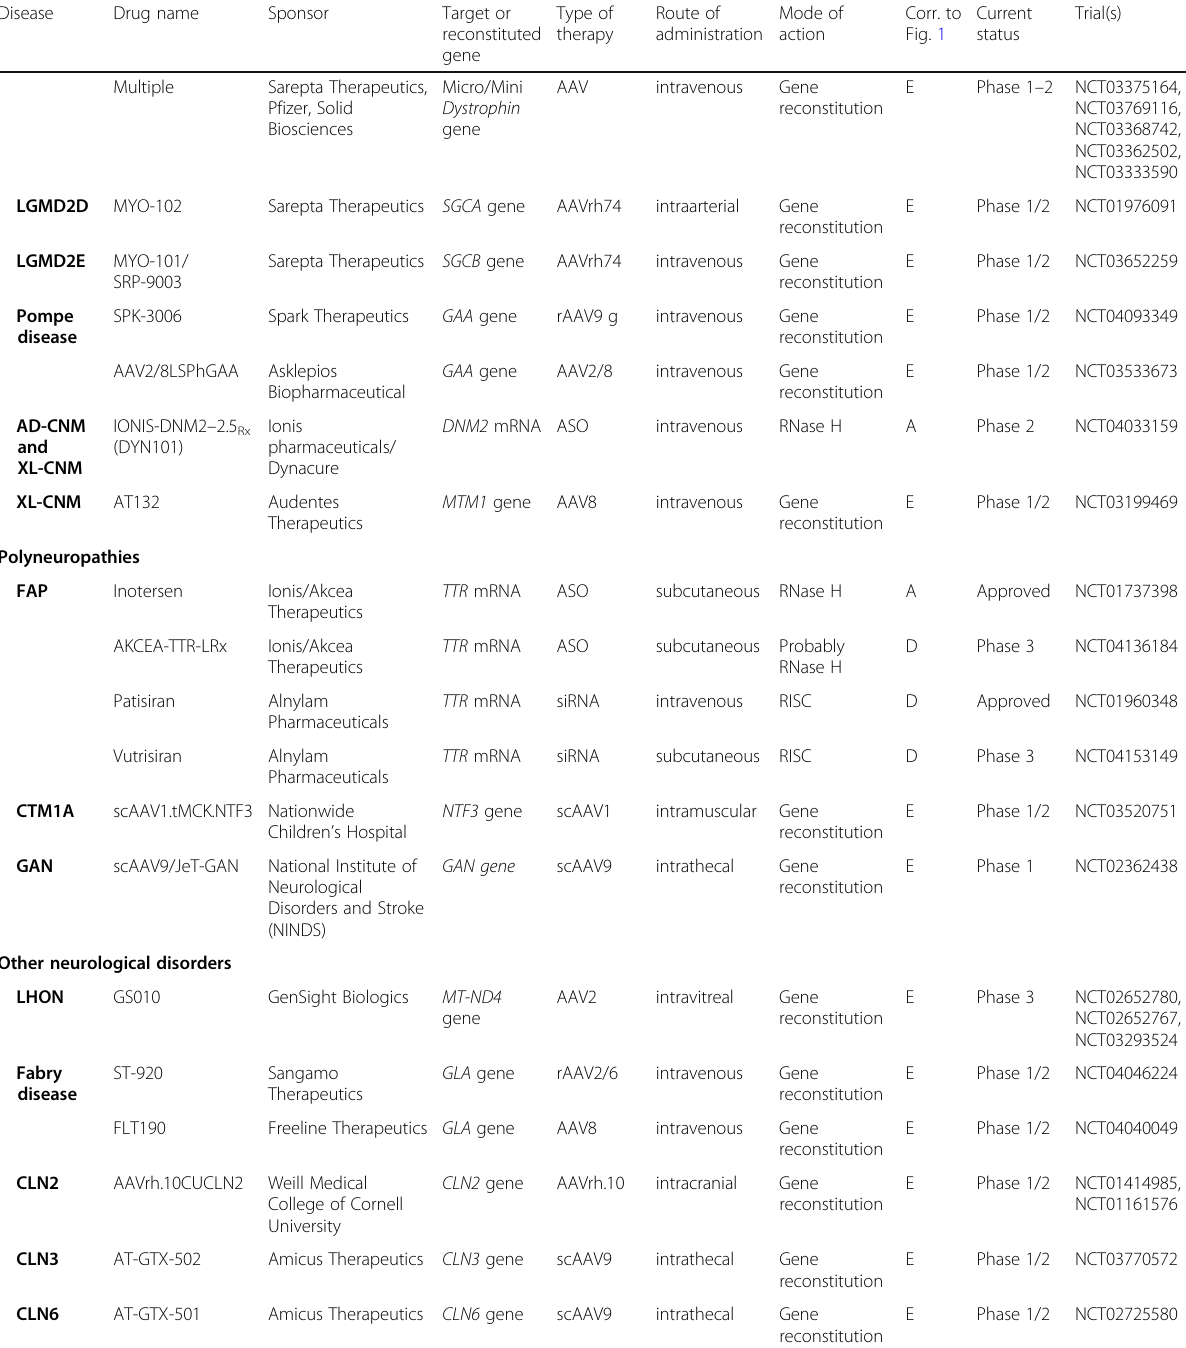
Table 1 Gene specific therapies approved for treatment or tested in clinical trials (Continued)